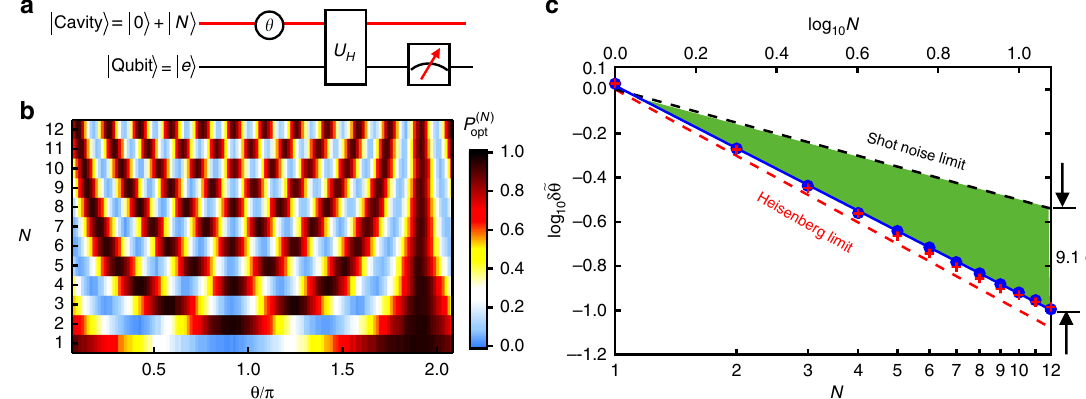
Fig. 2 Wigner functions of the maximum variance states. Theoretical (top panel) and experimental (bottom panel) results for 0 j i þ i N j ið Þ = fi delities of 0.94, 0.92, 0.83, 0.70 for N = 3, 6, 9, 12, respectively. The measured state preparation fi delity decays with N , mainly attributed to the larger probability of photon loss and the worse reconstruction measurement to obtain the Wigner functions for larger N . The measured range of the real and imaginary parts of α is [ − 3.0, 2.9] for N = 3 and 6, [ − 3.6, 3.5] for N = 9, and [ − 3.9, 3.8] for N = 12. The angles of the dashed sectors indicate that